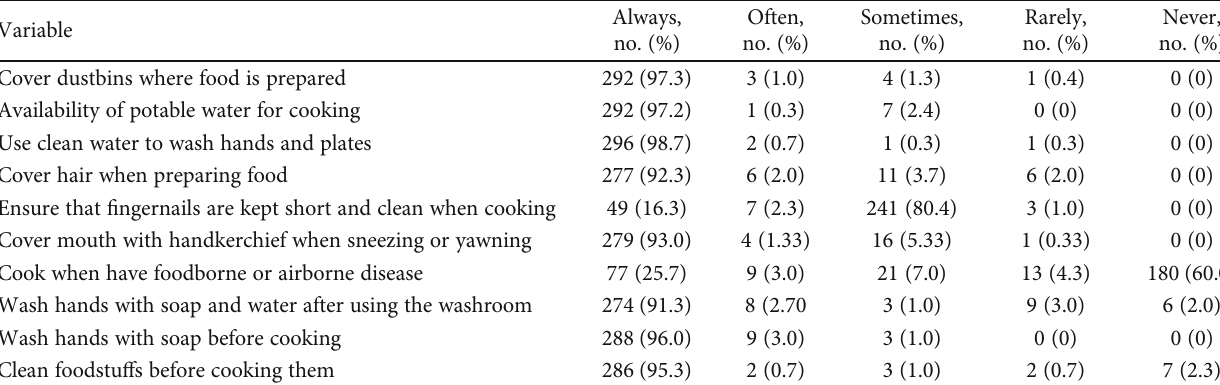
Table 3: Food preparation practices among the